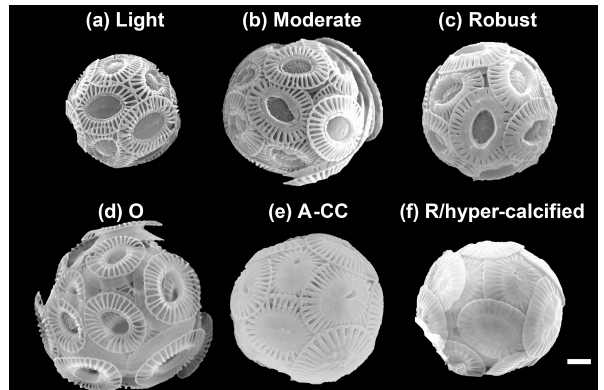
Figure 2. The main E. huxleyi morphotypes recorded in the sur- face waters of southern Patagonia fjords during the austral late spring 2015 and early spring 2017. The lightly, moderately, and ro- bustly calcified A morphotypes (top) and the O, A-CC, and R/hyper- calcified forms (bottom) are shown. For statistical analysis, the moderately and robustly calcified A morphotypes were merged under “moderately calcified A morphotype”, and the few O and C specimens were categorized into the lightly calcified subgroup. Scale bar =